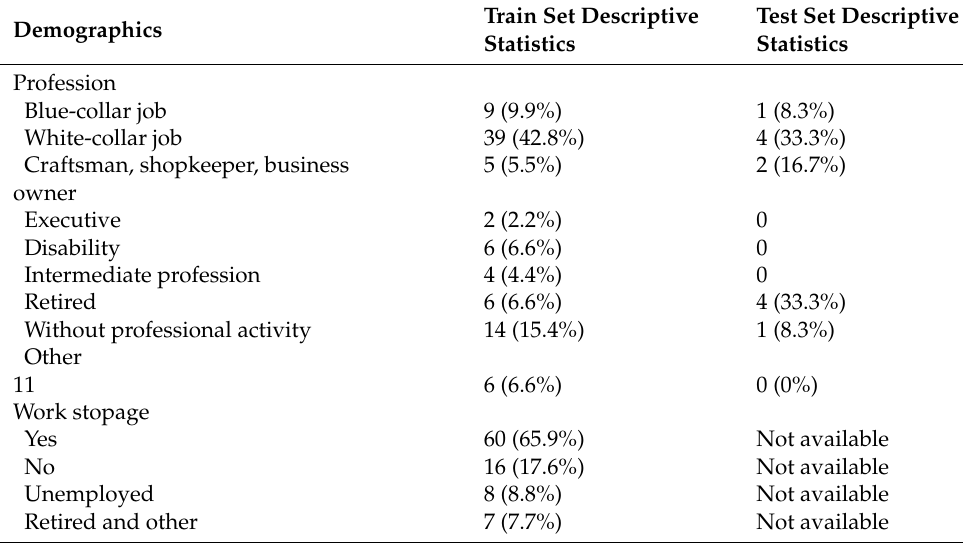
Table 1. Descriptive statistics of our 12-month outcome and baseline characteristics for both the training and testing